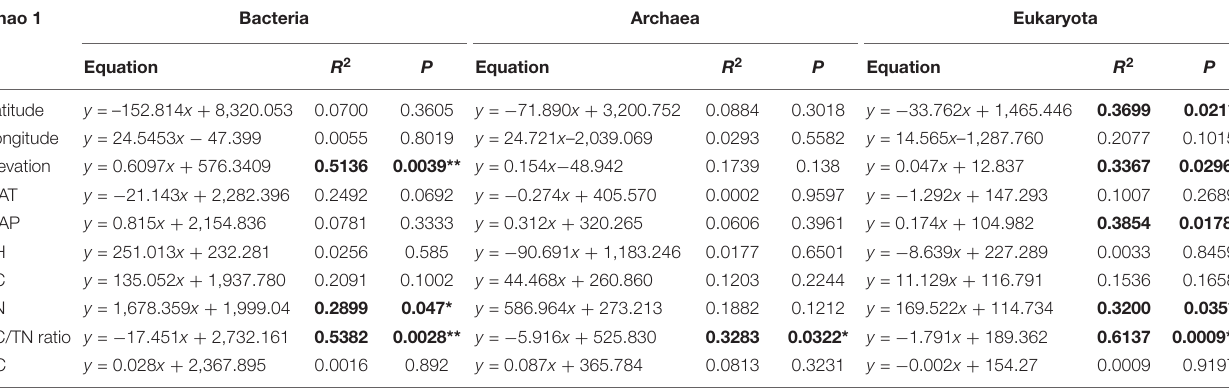
TABLE 1 | Results of the linear regression analysis for the relationships between the Chao1 index for the three groups of soil microbes and the environmental variables. Chao 1 Bacteria Archaea Eukaryota